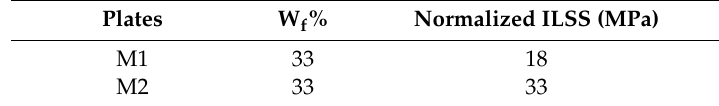
Table 7. Normalized average ILSS values of each set for a unified fiber weight fraction of